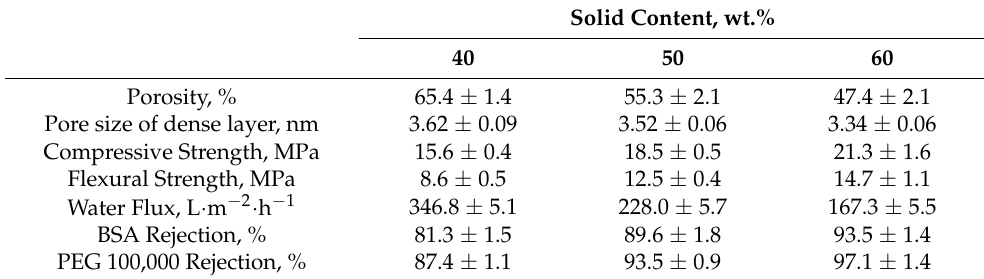
Table 1. Influence of solid content on the performance and pore structure of PCMs.